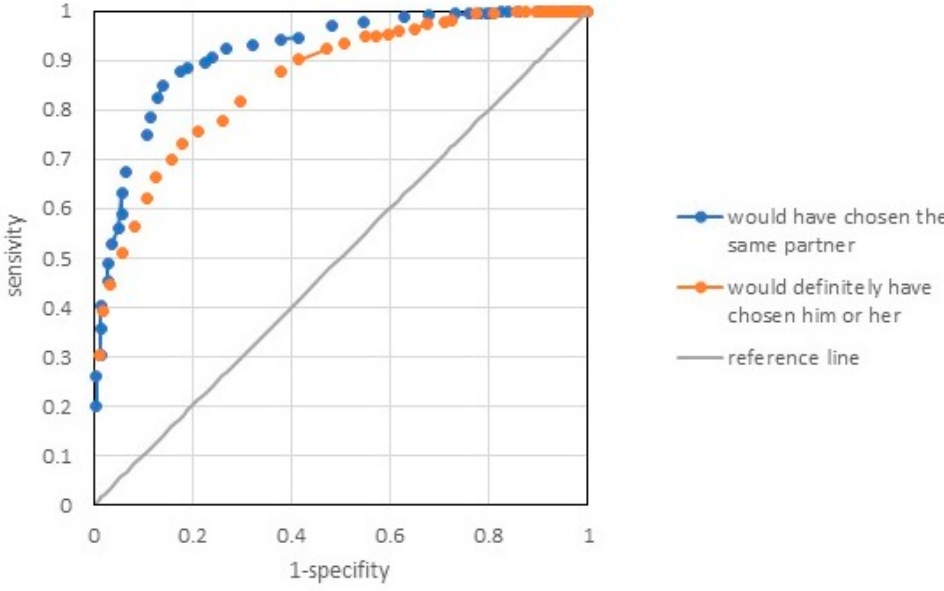
Figure 3. The receiving operating characteristics curve (ROC) of SLS-12 as a marker of good and very good relationships.